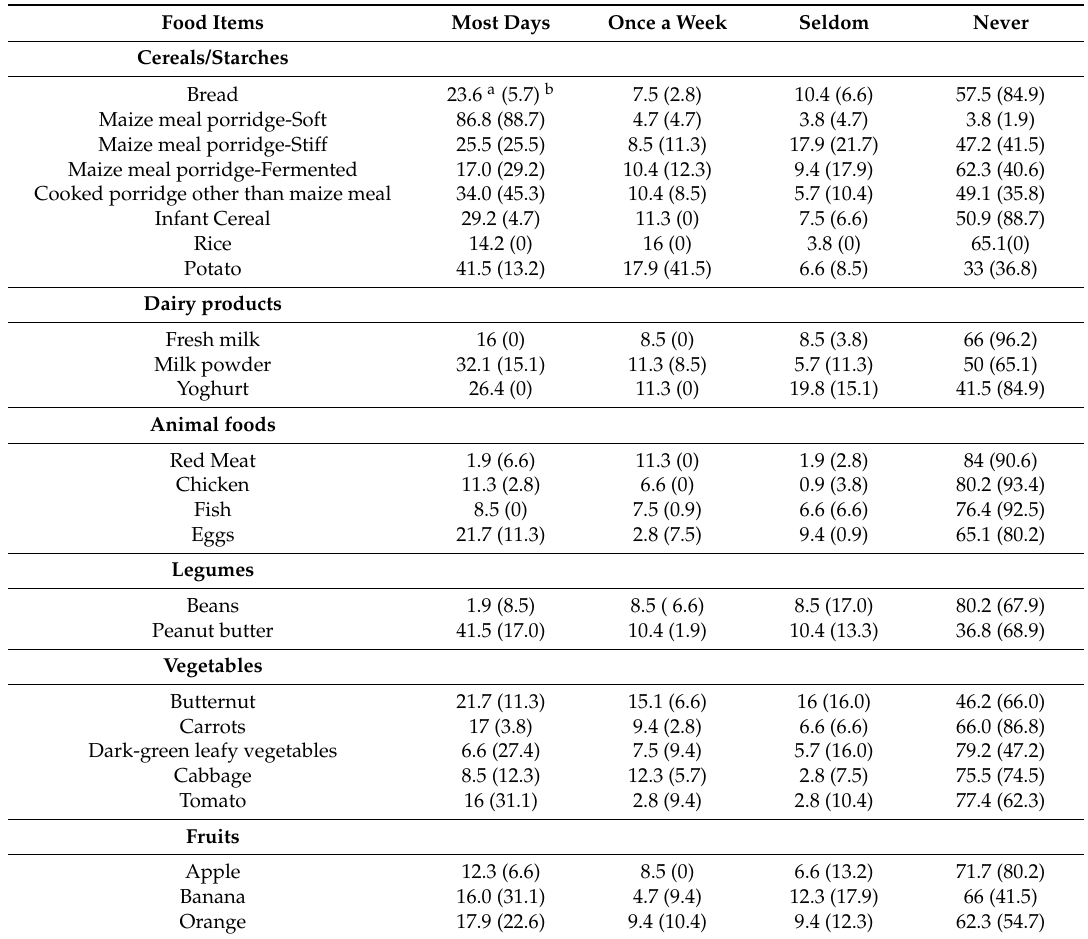
Table 2. The usual intake of food items by 7–12 months children as determined by an unquantified food frequency questionnaire (%) administered in two communities (Hammanskraal and